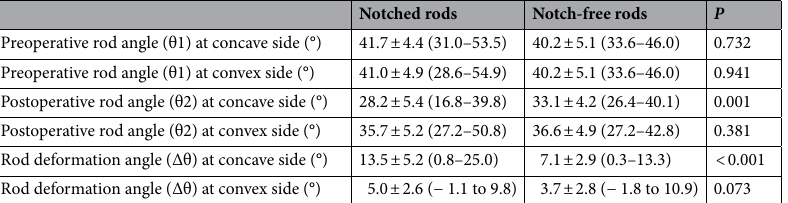
Table 4. Implant rod angle of curvature at the concave and convex side of deformity. All data expressed as means ± SD and range. Mann–Whitney U test. Δθ was defined as the difference between θ1 and θ2 (θ1–θ2).